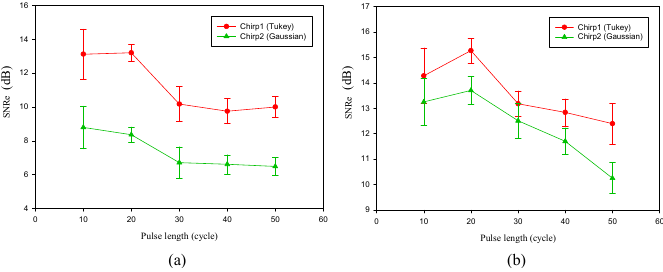
Figure 17. Elastographic signal ‐ to ‐ noise ratio (SNRe) for chirp pulse as a function of pulse length. Algorithm for ( a ) AD and ( b ) CC. The correlation window length is 0.77 mm.